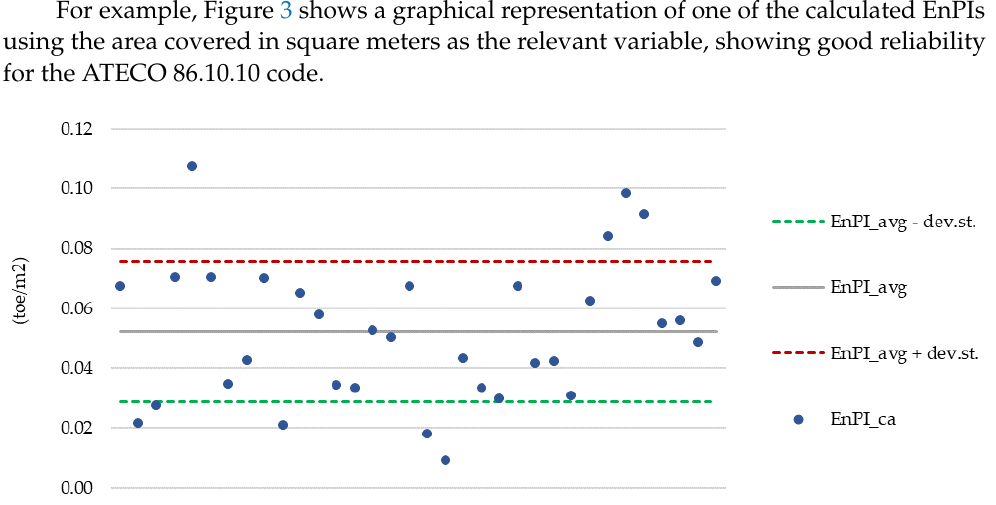
Figure 3. Graphical representation of EnPI bmk_ ca (toe/m 2 ) for the ATECO code 86.10.10.